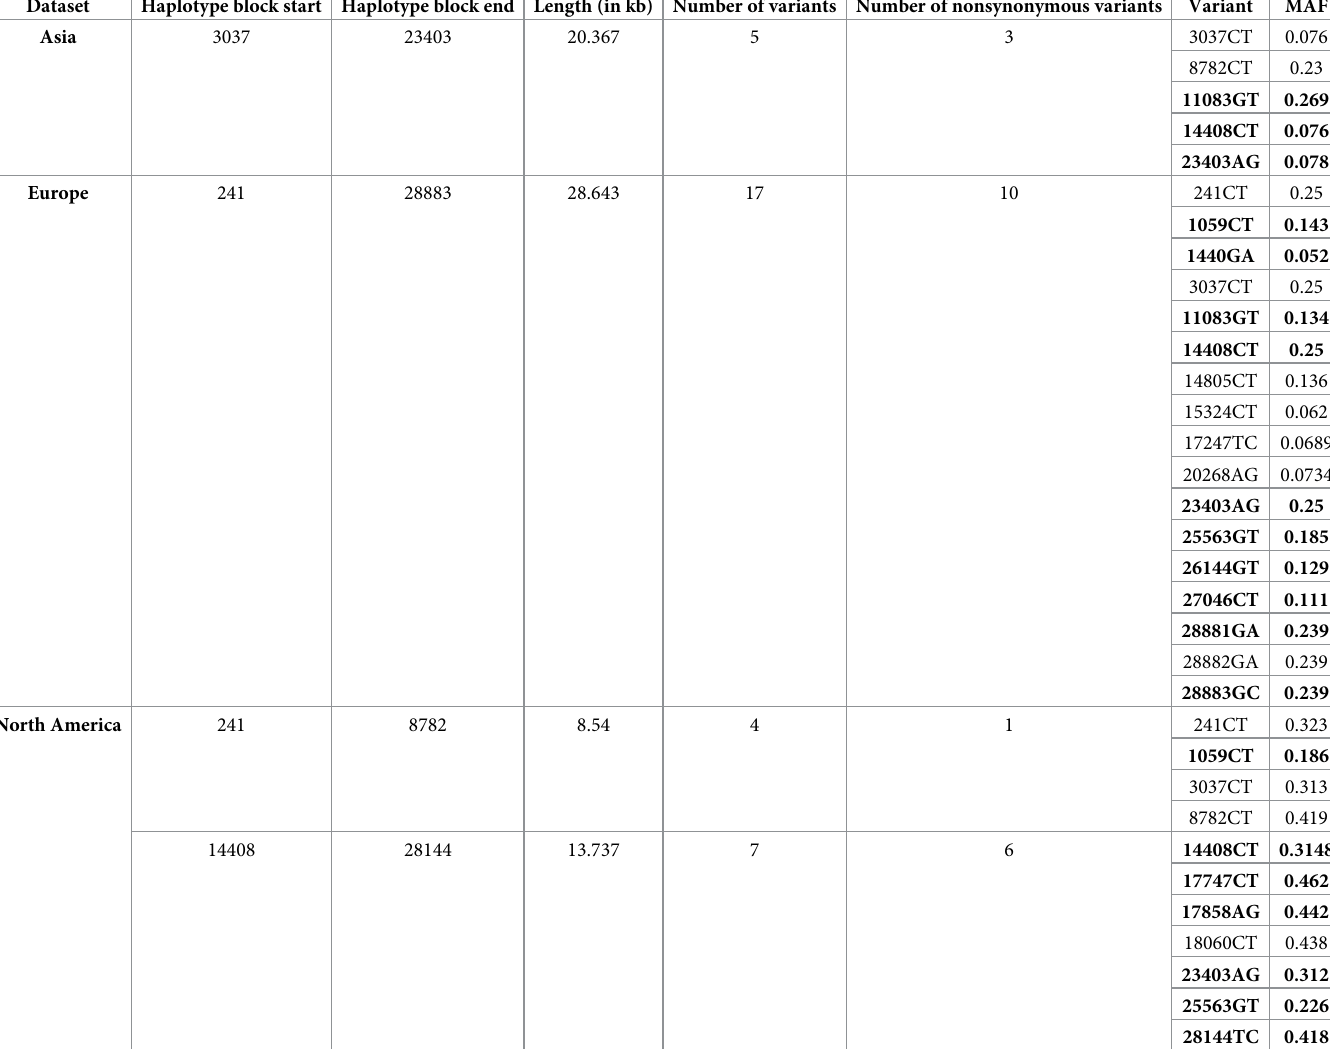
Table 4. Characteristics of haplotype blocks estimated from three continental